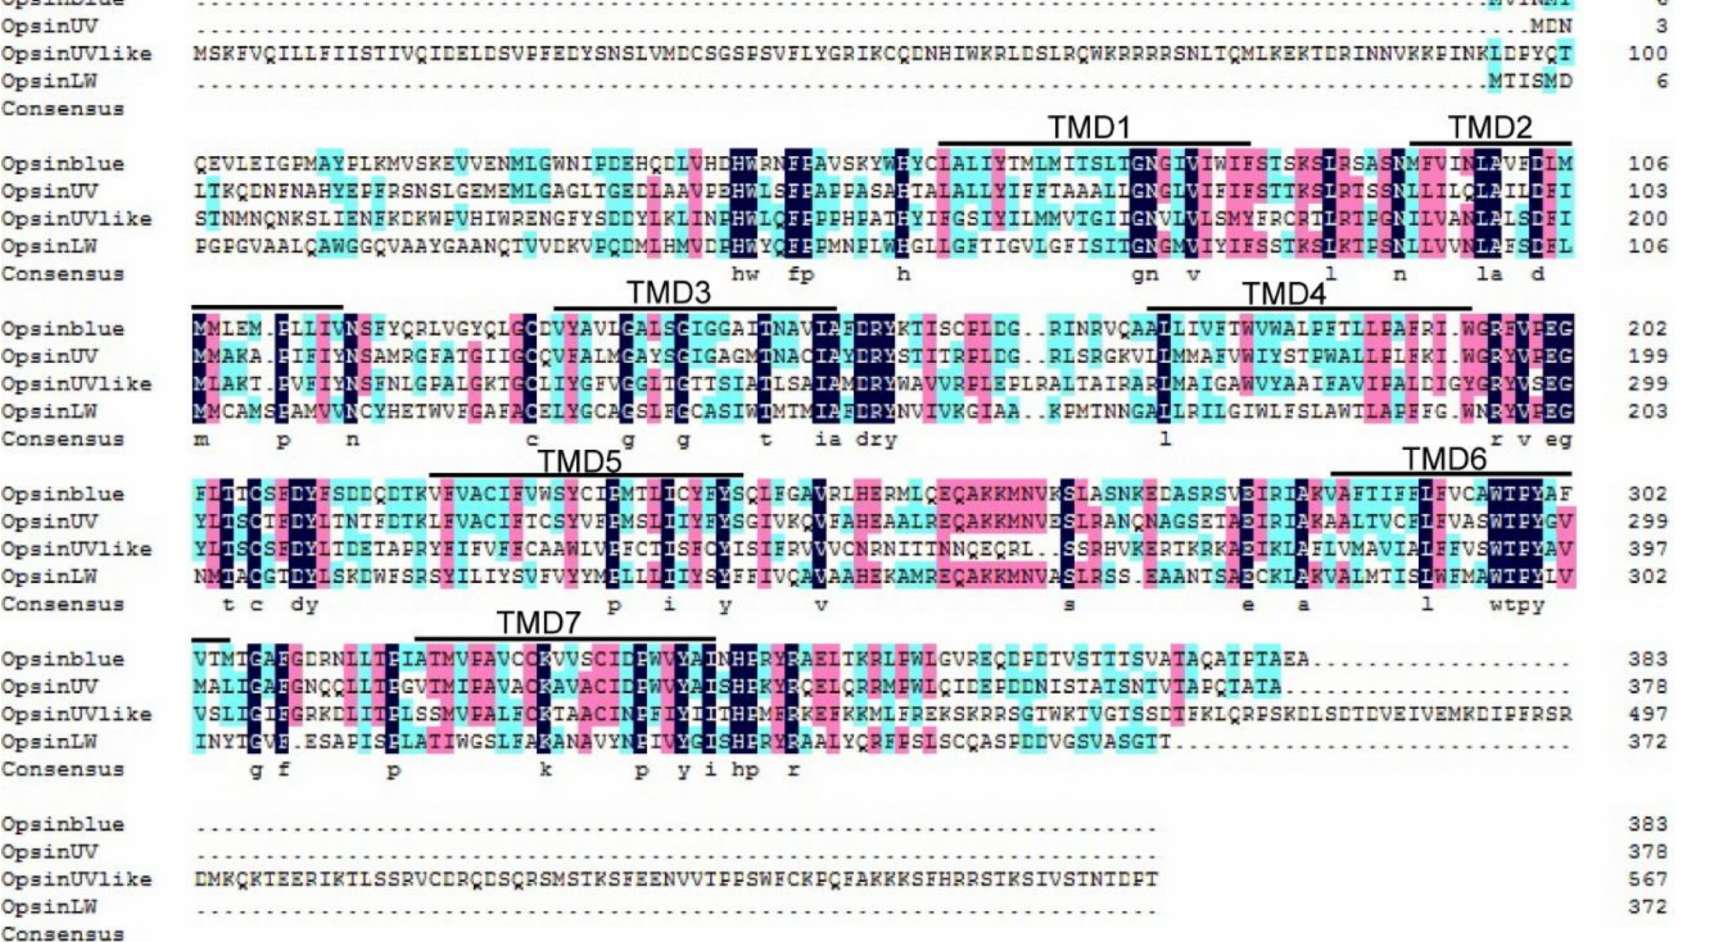
Figure 1. Sequence alignment of four opsins from Dendrolimus punctatus . The seven transmembrane domains are marked above the alignments as